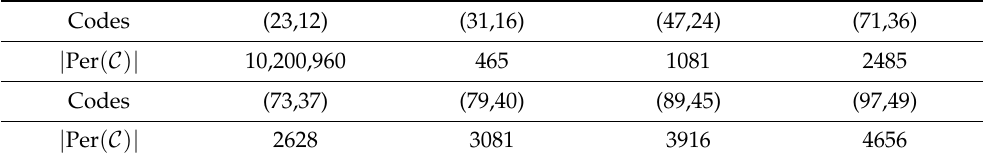
Table 1. The order of permutation groups for each QR